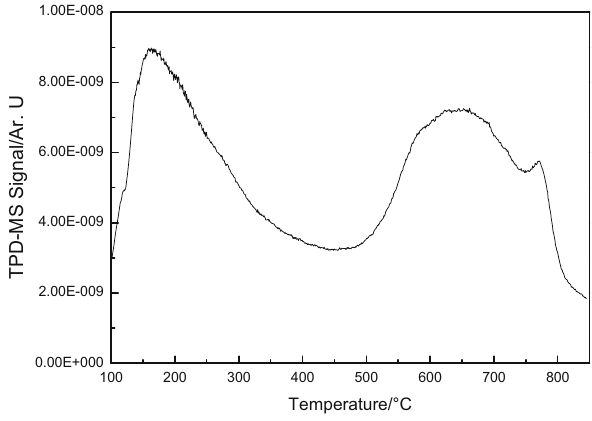
Figure 2: CO 2 - TPD of the catalyst.